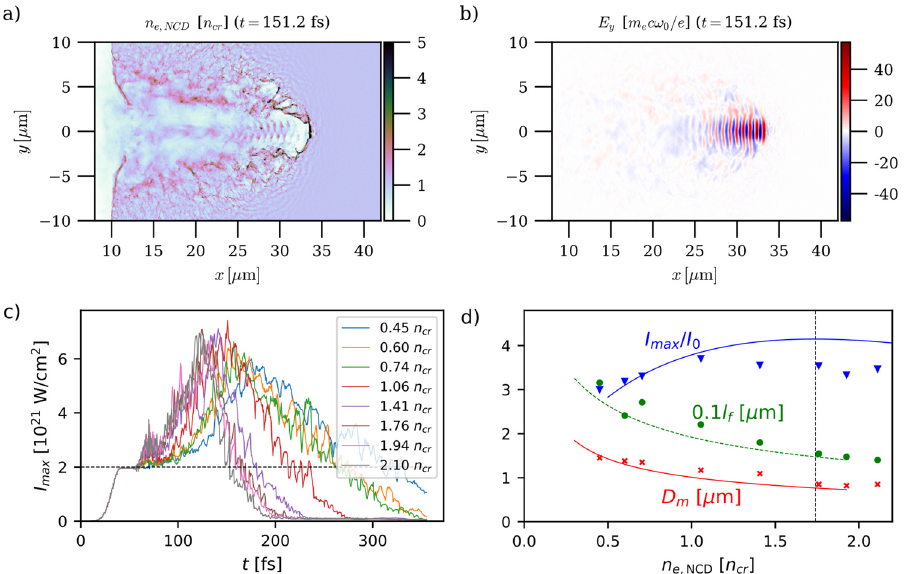
Figure 2. Relativistic self-focusing of a 2 × 10 21 W cm -2 , 20 fs duration laser pulse in near-critical plasmas. Spatial distributions of ( a ) the electron density n e (saturated colormap) and ( b ) E y electric field component for an initial plasma electron density n e ,NCD = 1.06n cr at the simulation time t = 136.9 fs , i.e., 99.3 fs after the laser pulse maximum entered the simulation box. ( c ) Time evolution of the instantaneous peak intensity of the laser pulse during its propagation through the plasma for eight different values of n e ,NCD . The horizontal dashed line indicates the peak laser intensity in vacuum, I 0 = 2 × 10 21 W cm − 2 . ( d ) Dependence of the maximum intensity increase factor I max / I 0 (blue triangles and solid line), focusing distance l f (green circles and dashed line), and FWHM spot size D m (red crosses and solid line) of the laser pulse on the initial plasma density. The symbols represent the PIC simulation results while the curves correspond to the formulas given by Pazzaglia et al. 43 . The vertical dashed line indicates the plasma density yielding the best focusing according to analytical theory.